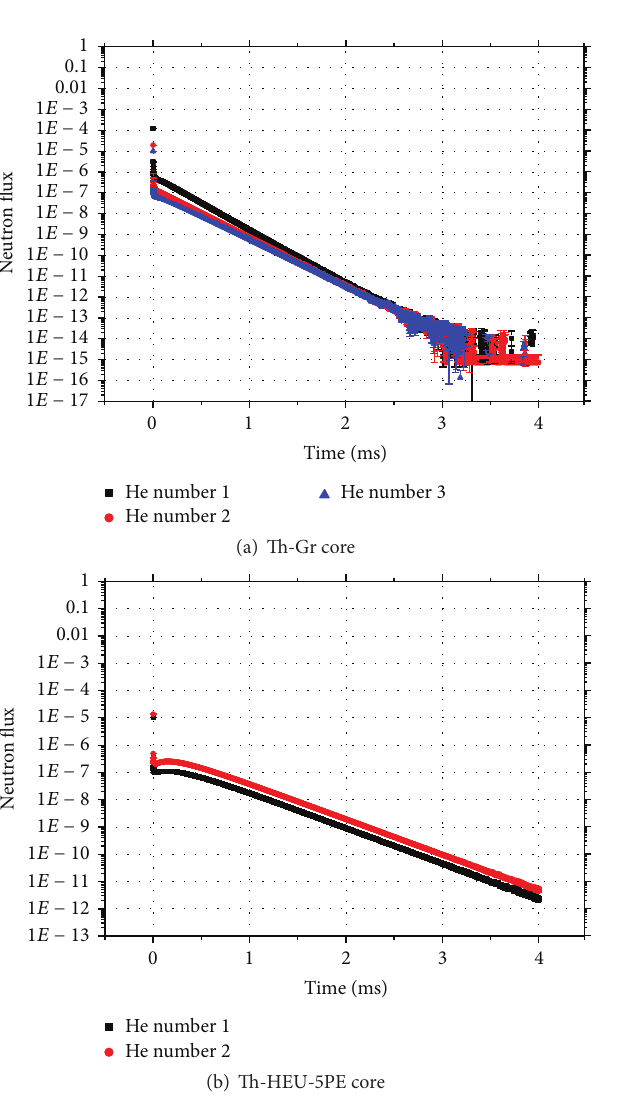
Figure 4: Fitted 𝛼 values according to the starting time of fitting for the Th-ADS benchmark